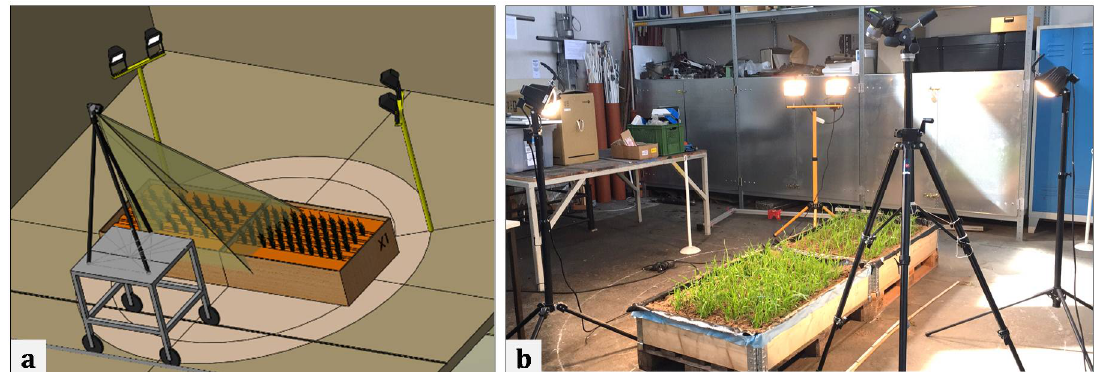
Figure 3. Laboratory experiment setup showing ( a ) the preliminary simulation tests, and ( b ) the actual laboratory experi- ments with wheat plants in the early growth stage. The platform moves a distance of 10 cm in each iteration.